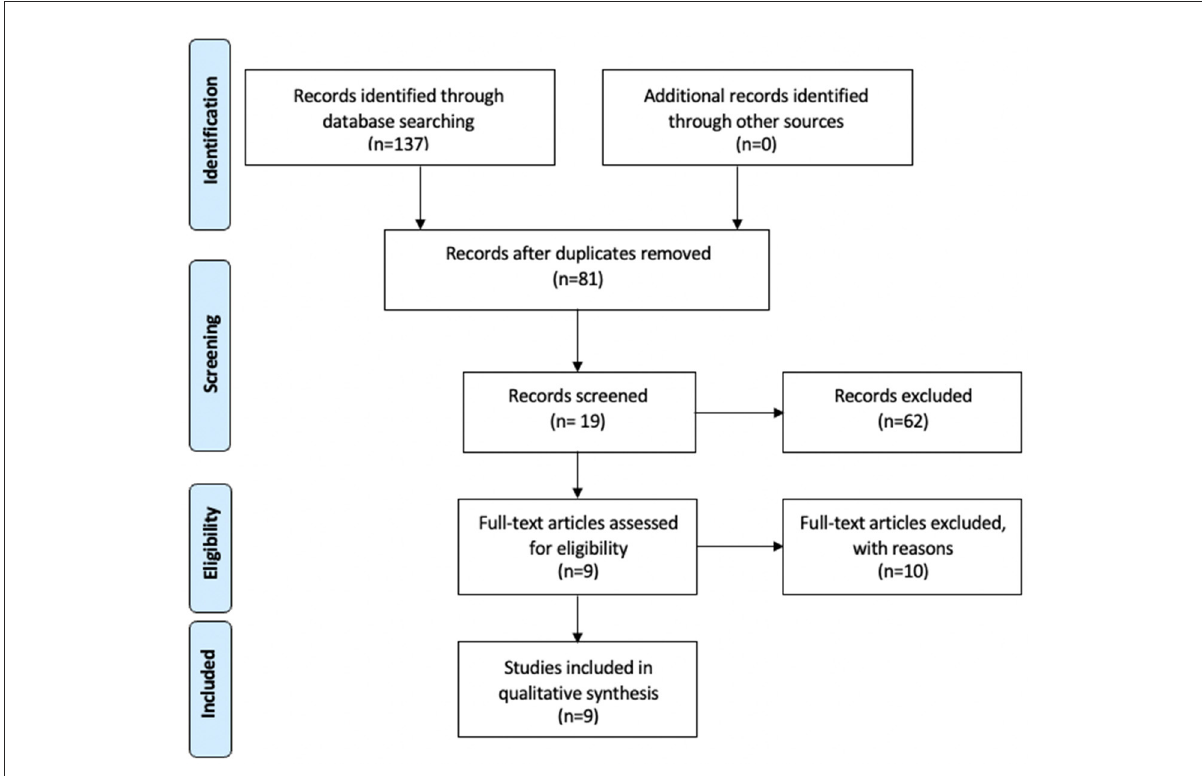
FIGURE1 PRISMA flow diagram.